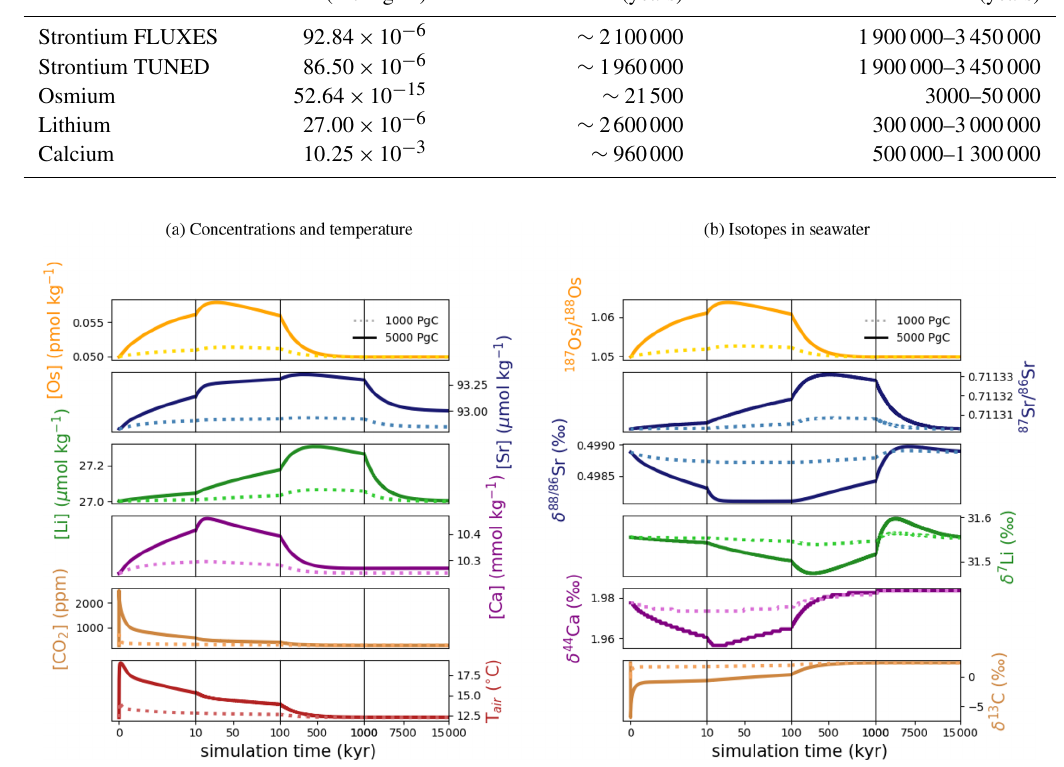
Figure 7. Transient changes in modeled Sr, Os, Li, Ca, composition of seawater, and atmospheric CO 2 and temperature following instant releases of 1000 and 5000PgC. Shown are changes (a) in concentrations, and (b) in the isotopic composition of